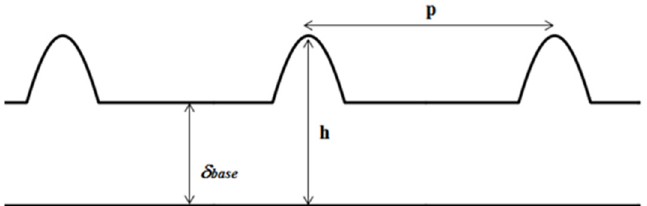
Figure 4. A mathematical model describes the base film and the interfacial wave features at the pipe wall. δ base is the base film thickness; h is the initial height of the wave and p depicts the wave spacing between the wave celerity.